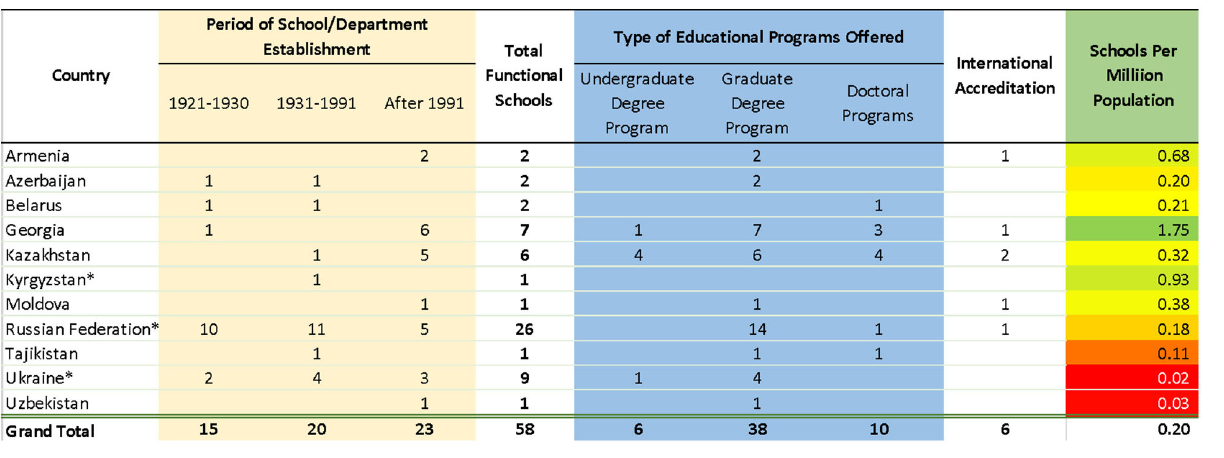
TABLE 1 | Schools and departments in Former Soviet Union